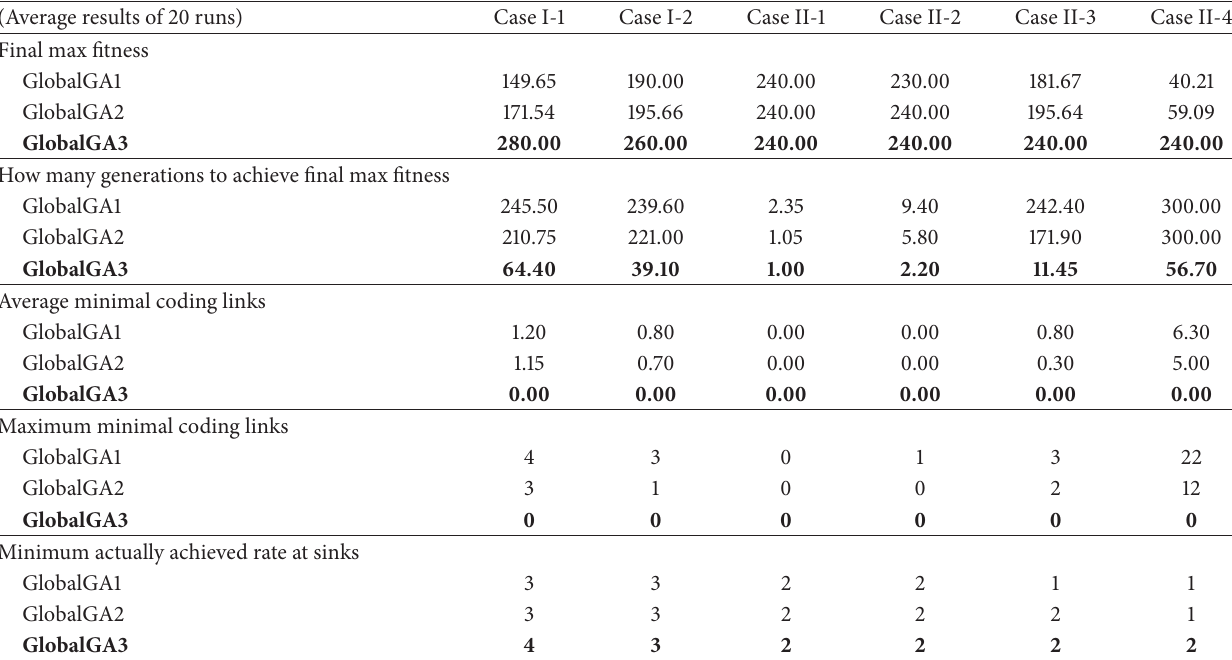
Table 3: Details of the results of the new